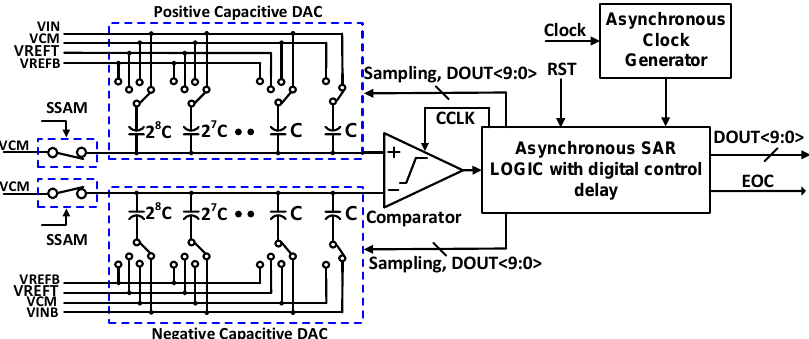
Figure 1. Proposed asynchronous successive approximation register (SAR) analog-to-digital (ADC) architecture.